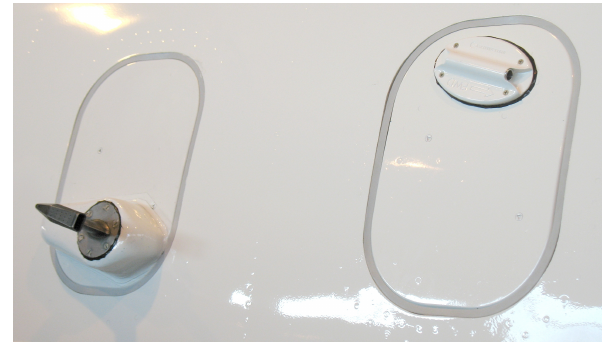
Figure 1. External view of WVSS-II fitted to FAAM aircraft show- ing the two inlets (Rosemount, left; flush, right) angled down to match the local air flow in